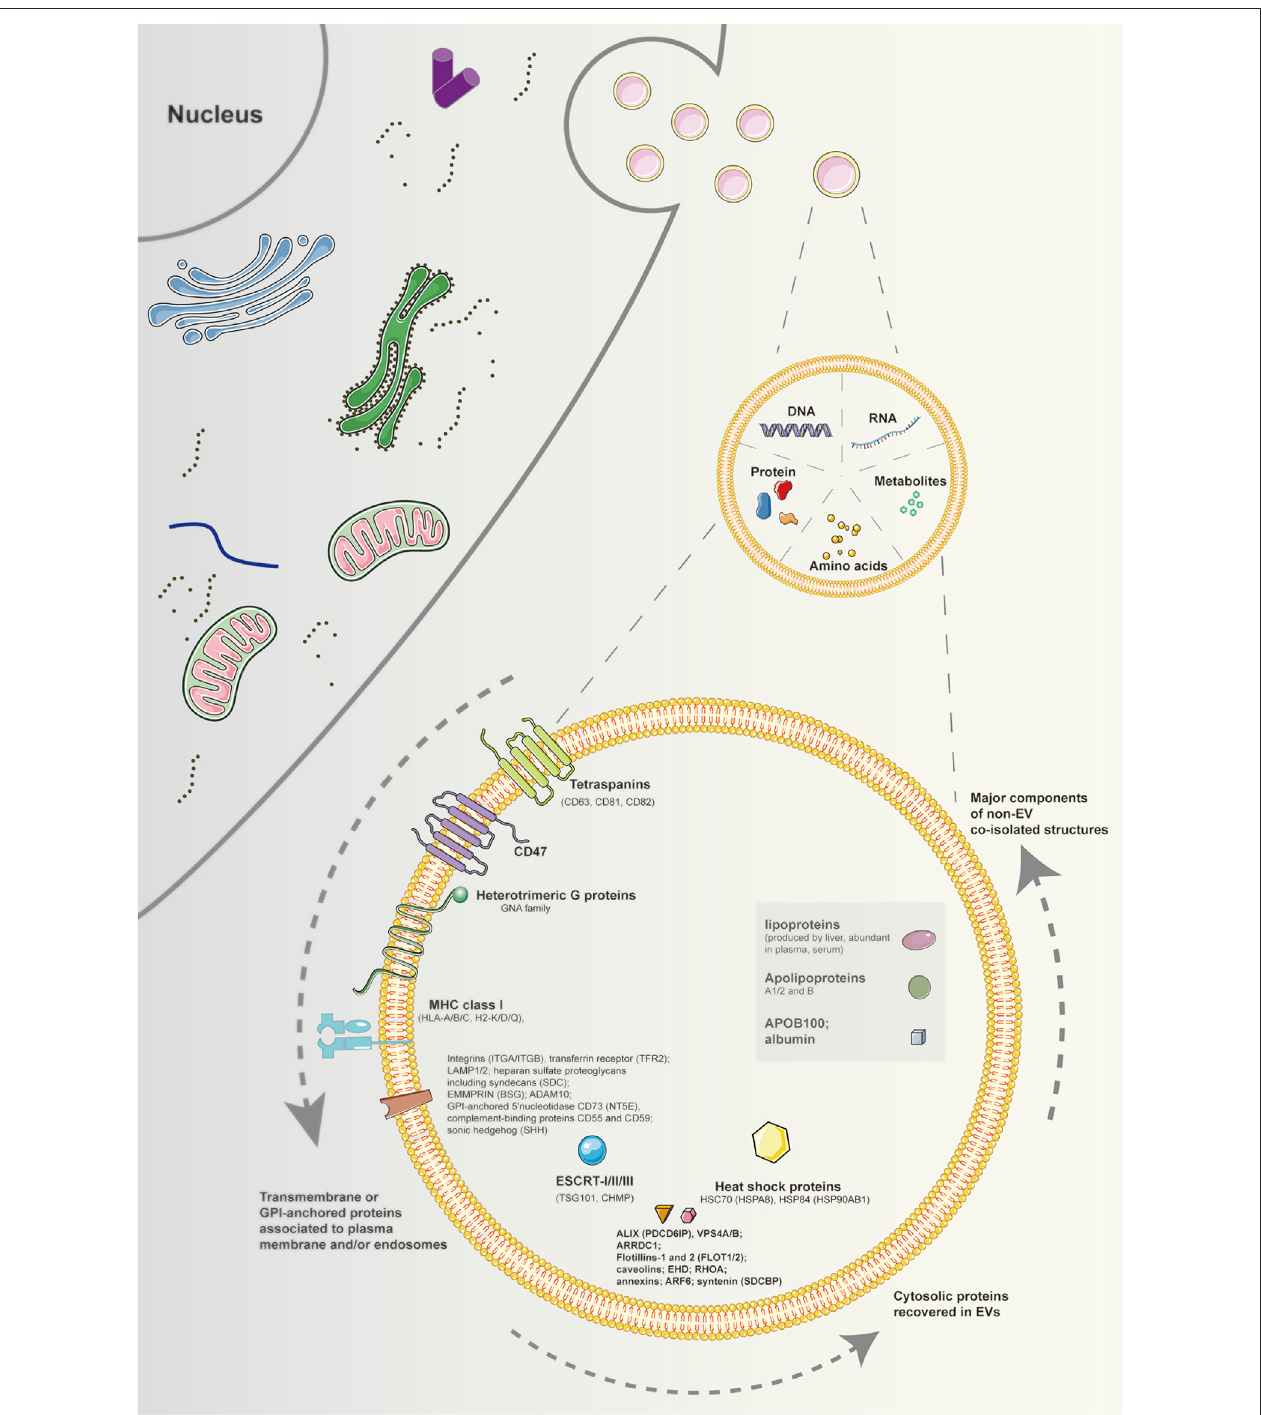
FIGURE 1 | Schematic diagram of components and markers of extracellular vesicles. EVs are particles naturally released from the cell that are delimited by a lipid bilayerandcannotreplicate.ThecomponentsofEVscontainDNAs,RNAs,proteins,aminoacids,metabolites,andsoon.RegardingproteinmarkersofEVs,atleastone protein of transmembrane or GPI-anchored proteins associated to plasma membrane and/or endosomes, cytosolic proteins recovered in EVs, and major components of non-EV co-isolated structures must be analyzed to demonstrate the EV nature and the degree of purity of EV preparation. Note: EVs, extracellular vesicles; GPI, glycosylphosphatidylinositol.